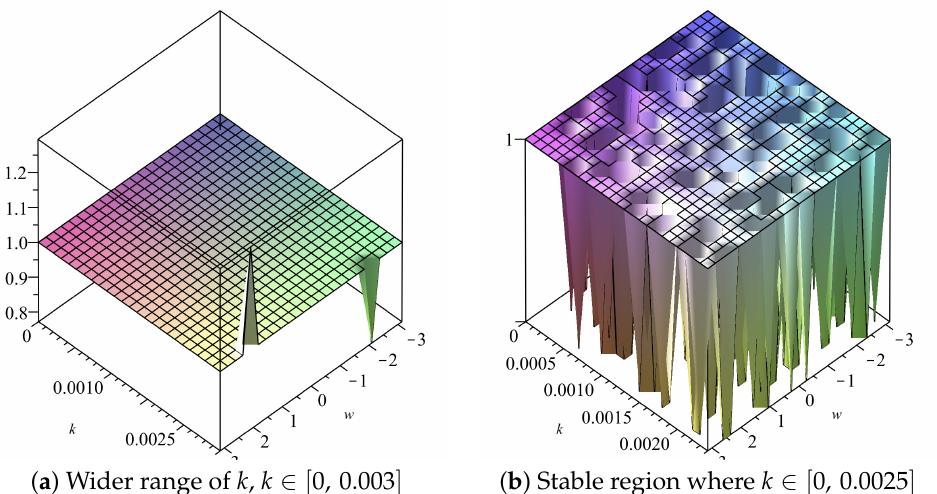
Figure 16. Plot of | ξ 1 | vs. k vs. w ∈ [ − π , π ] of Scheme 1 for Numerical Experiment 2. The spatial step size h = π